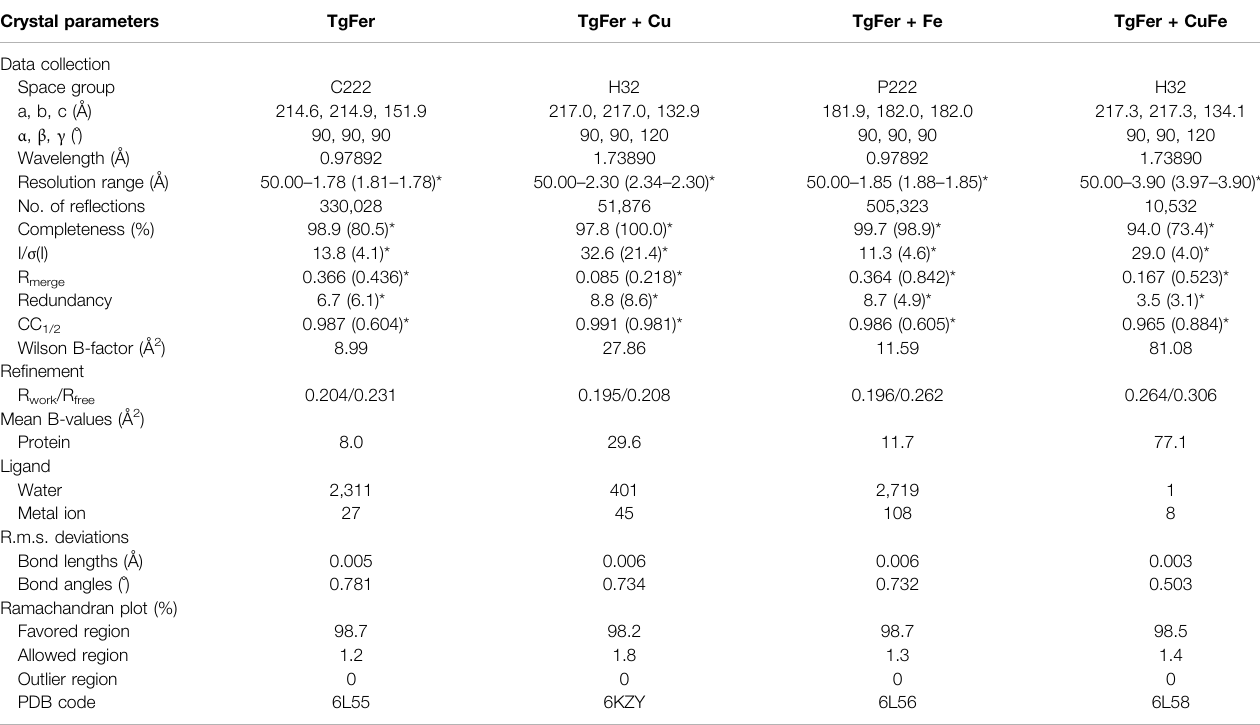
TABLE. 1 | Data collection and re fi nement statistics. Crystal